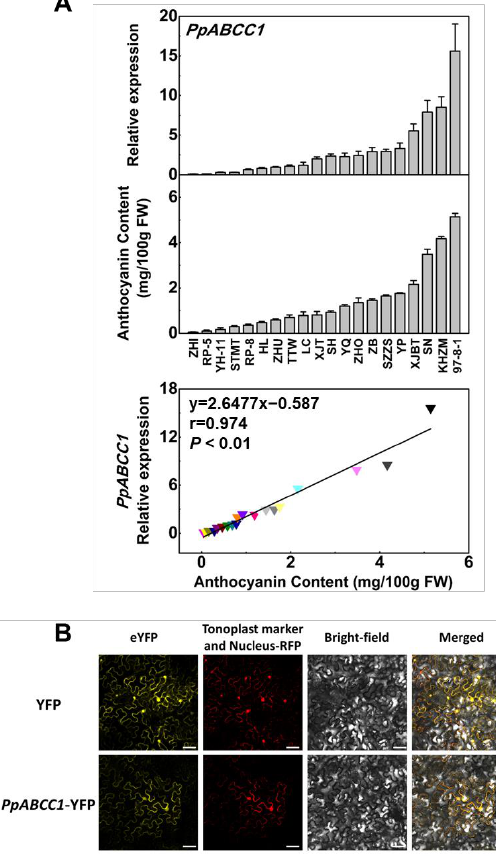
Figure 6. Expression and subcellular location for the PpABCC1 gene: ( A ) expression of PpABCC1 and anthocyanin content in ripe fruits of 20 peach cultivars and the correlation analysis between the PpABCC1 expression and anthocyanin content. Data represent means (±SD) of three biological replicates; ( B ) subcellular localization assay of PpABCC1 in tobacco leaves. Scale bars indicated 50 μm.